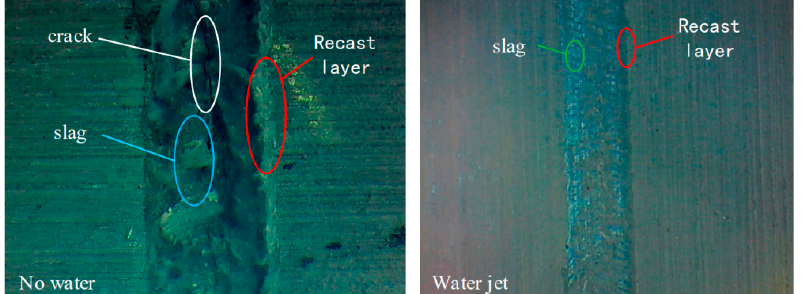
Figure 11. Graph of laser processing results. Reprinted from [67], with permission from MDPI jour- nals. Feng et al. [68] considered the interaction between laser–water-jet workpieces to es- tablish a three-dimensional analysis model of the temperature field in water-jet-assisted laser micromachining. It was found that in the water-jet-assisted laser processing, the re- moval temperature of the material is lower than the melting point of the material due to the cooling effect of the water jet. The maximum temperature increased with increasing the laser power and water-jet offset distance, and with decreasing the nozzle-outlet diam- eter. Bao et al. [69] used smooth-particle hydrodynamics (SPH) technology to construct a water-jet-fluid dynamic model and performed water-jet-laser cutting silicon materials. The simulation results show that the melt jet disturbs the water and may cause laminar and turbulent flow in the water, and the water jet can take the molten silicon away from the workpiece surface. Chen et al. [70] investigated the energy efficiency, groove width, depth, and surface microstructure in low-pressure water-jet-assisted laser processing of polysilicon. The study found that the low-pressure water-jet-assisted laser etching technology could re- duce the defects existing in traditional laser processing. Wang et al. [71] performed a water-jet-assisted laser processing microchannel exper- iment on a stainless-steel surface and used the response surface method to study the in- fluence of various process parameters on the microchannel processing quality and heat- affected zone. The response surface method was used to study the influence of various process parameters on the quality of microchannel processing and the heat-affected zone.